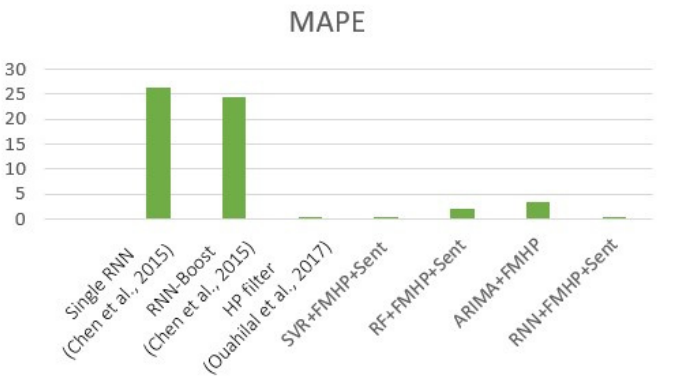
Figure 10. Comparison of error rates of the proposed model with Chen et al. [14] and Ouahilal et al. [15].